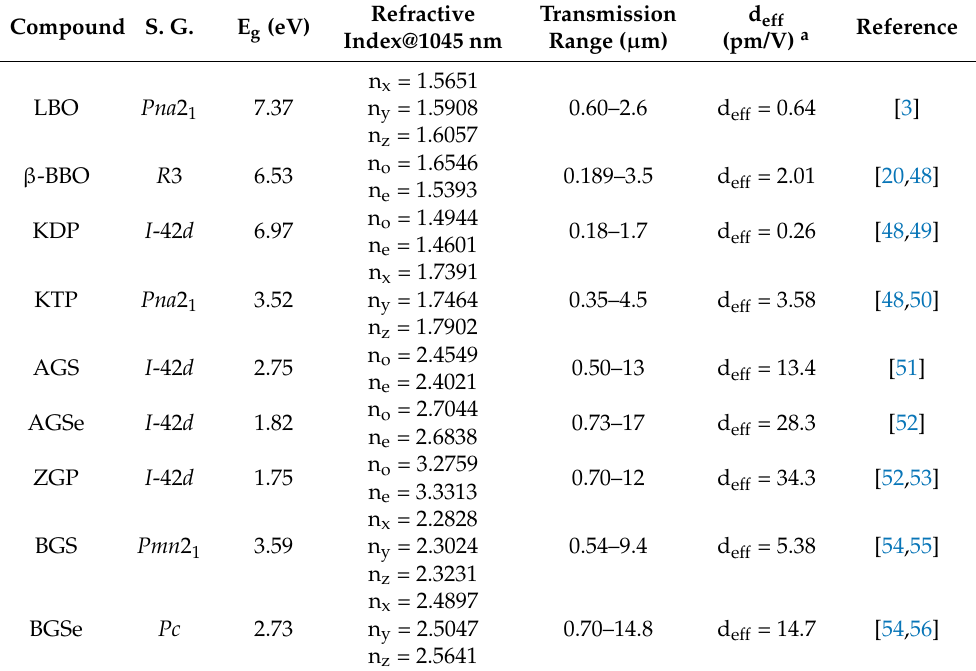
Table 1. Crystallographic information and linear and nonlinear optical properties of some known crystals. Compound S. G.